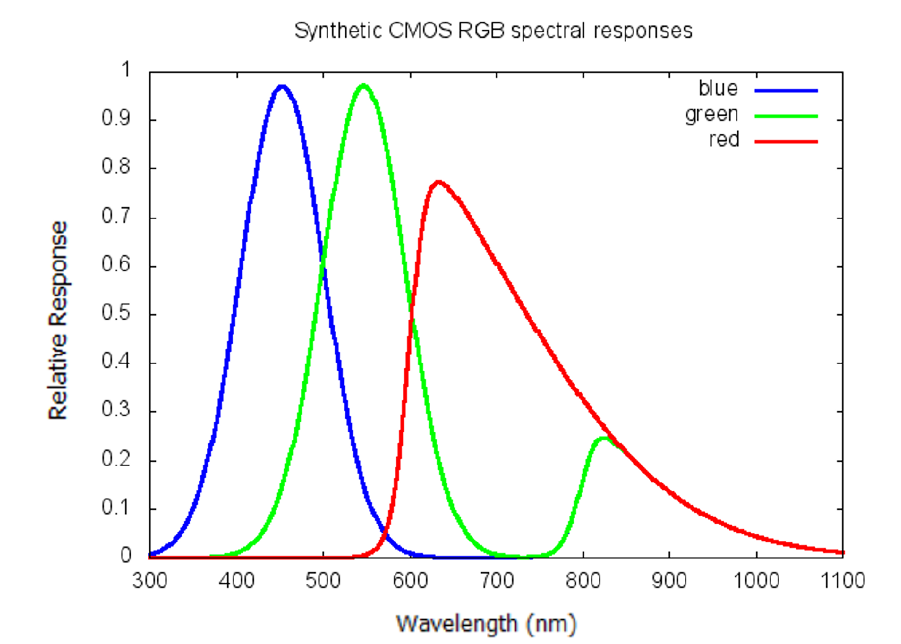
Figure 6. Synthetic spectral responses of the Red, Green, and Blue components of a CMOS camera. The Red, Green, and Blue channels have peak sensitivities above 600 nm (Red), near 550 nm, and above 800 nm (Green), near 450 nm, and above 800 nm